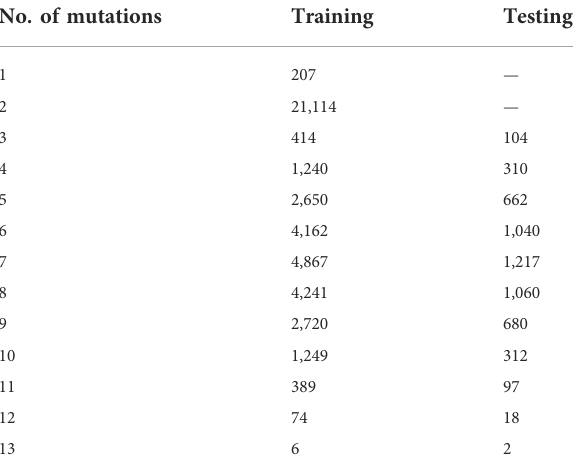
TABLE 1 Counts of sequences in training and testing data